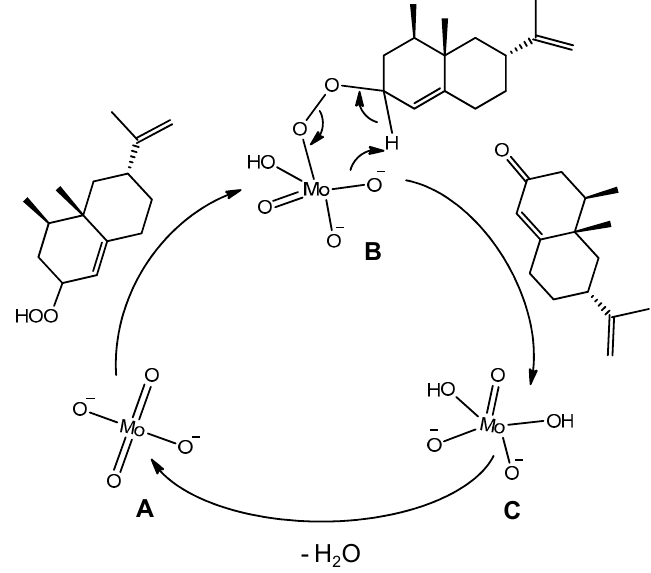
Figure 5. Proposed catalytic cycle for the [DiC 8 ] 2 MoO 4 -catalyzed dehydration of hydroperoxide 4 .